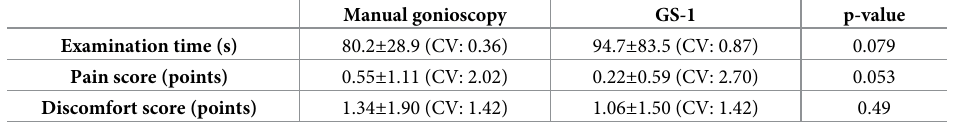
Table 2. Comparison of the examination time, pain score, and discomfort score between manual gonioscopy and automated gonioscopy (GS-1).